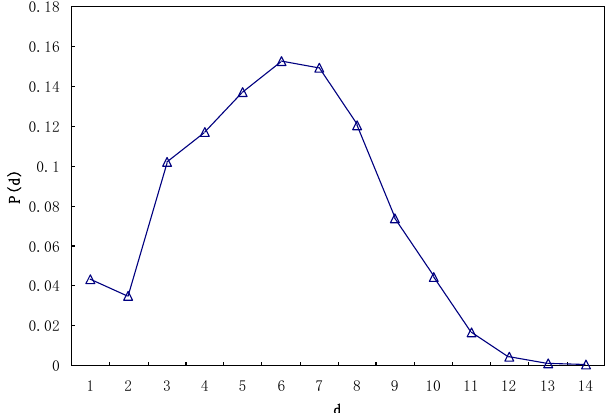
Figure 2. Sandstone pore network’s shortest path distribution. The degree distribution of the network nodes is the number of cracks connected to this node. The node degree distribution of the sandstone pore network is shown in Figure 3. P ( k ) represents the proportion of all degree distributions in the whole network when the degree distribution is k . Figure 3 shows that 80% of the network nodes had degrees less than or equal to 3, and those with degrees equal to 3 accounted for more than 50% of the total nodes. This indicates that the permeability would be significantly affected only when the nodal degree distribution value was at a certain intermediate value. The nodes with a larger degree significantly reduced the average shortest path of the network, while the nodes with a smaller degree expanded the coverage of the seepage network.